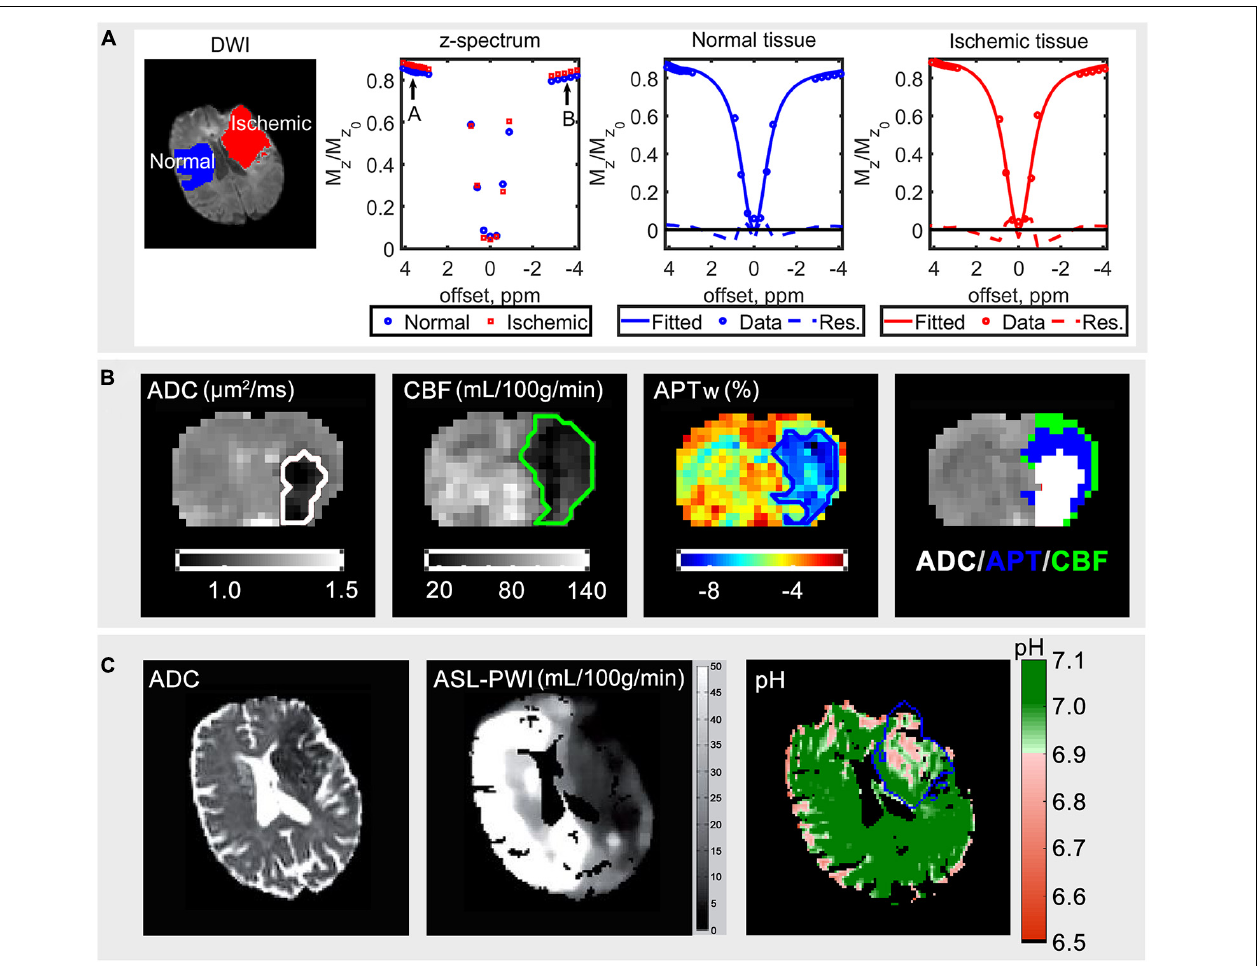
FIGURE 2 | (A) Diffusion weighted imaging (DWI) data for b = 1,000 s/mm 2 of an ischemic stroke patient, the average acquired z-spectrum of normal and ischemic tissue, fitted spectrum in the normal and ischemic tissue from left to right, modified from Tee et al. (2014). (B) The ADC ( µ m 2 /ms), cerebral blood flow (CBF) (mL/100 g/min), APT-weighted (APWw) (%) images, and ADC/APT/CBF mismatch of an animal that underwent middle cerebral artery occlusion; the order of display priority of the mismatch map is white (ADC) > blue (APT) > green (CBF). (C) The ADC, arterial spin labeling perfusion weighted imaging (ASL-PWI) (mL/100